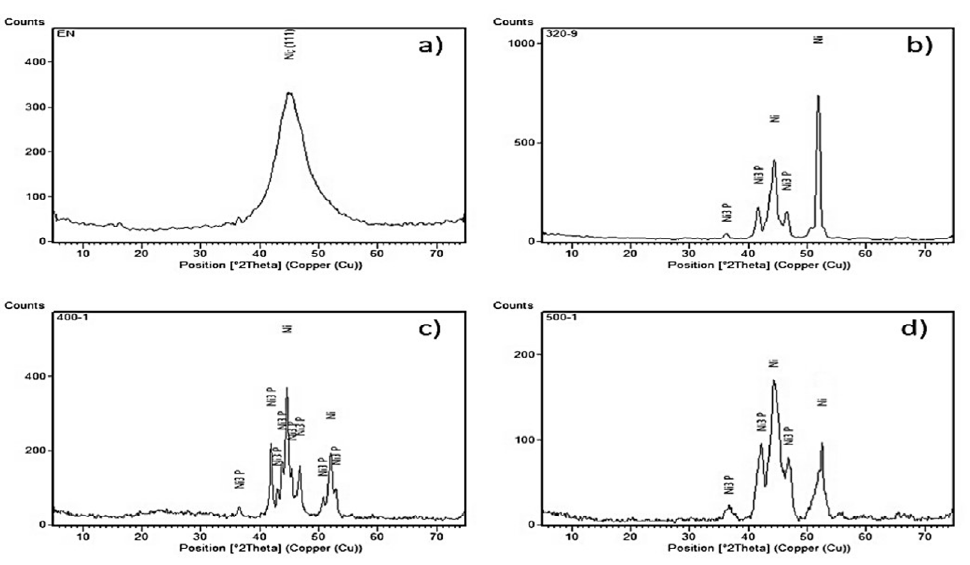
Figure 2. XRD patterns for electroless Ni-P coatings at different heat treatment conditions: a) EN as-deposited; b) EN 320-9; c) EN 400-1; d) EN 500-1.